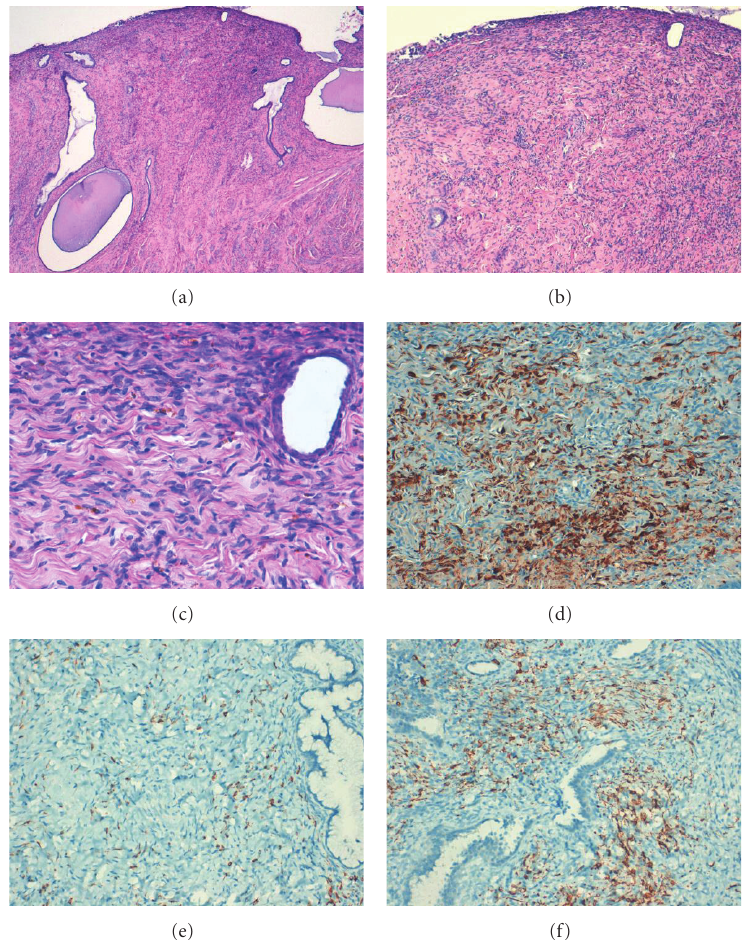
Figure 5: Uterine cervical blue nevi. Histopathologic findings. (a, b, and c) Upper stromal proliferation of focal pigmented melanocytes. The tumor cells are arranged in sheets and mostly spindle eosinophilic cytoplasm. Intracytoplasmic melanin is present. (d, e, and f) The tumor cells showed positivity for S-100, Melan A, and HMB-45,